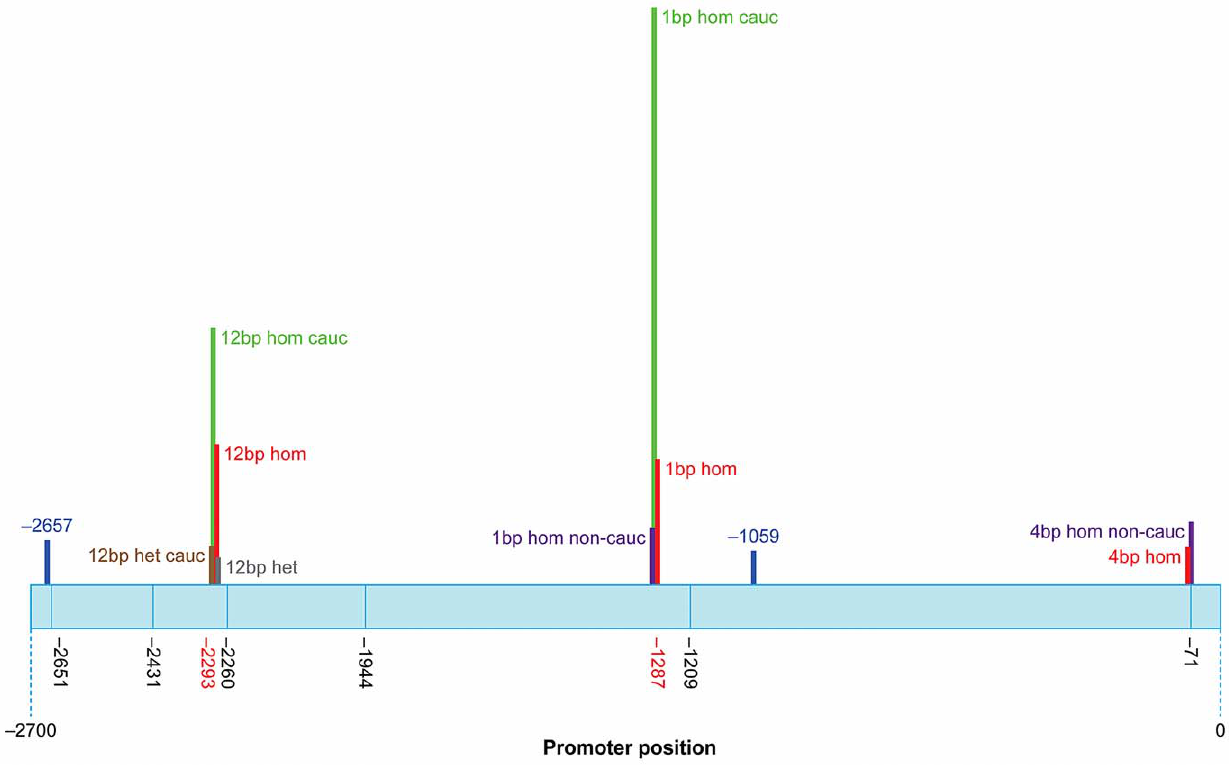
Figure 2. Schematic representation of the human D Np63 promoter showing SNP and indel locations. The height of the bars represents the Odds Ratio (OR). Promoter positions of SNPs and indel that are not associated with any significant change in risk of BEEC are shown in black. OR represented: 12 bp heterozygous (het) all patients (grey; OR=1.763); 12 bp homozygous (hom) all patients (red; OR=10.80); 1 bp hom all patients (red; OR=8.794); 4 bp hom all patients (red; OR=2.722); 12 bp het Caucasian patients (brown; OR=2.357); 12 bp hom Caucasian patients (green; OR=18.33); 1 bp hom Caucasian patients (green; OR=44.10); 1 bp hom Non-Caucasian patients (purple; OR=4.513); 4 bp hom Non-Caucasians patients (purple; OR=4.583). Two SNPs associated with decreased risk of BEEC are shown in blue: SNP 2 1059 (OR=2.164); SNP 2 2657 (OR=3.060).